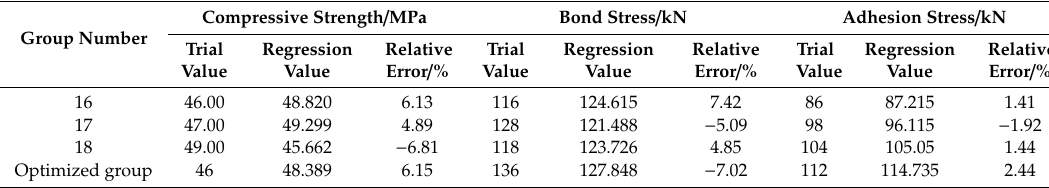
Table 13. Error analysis of the fitting